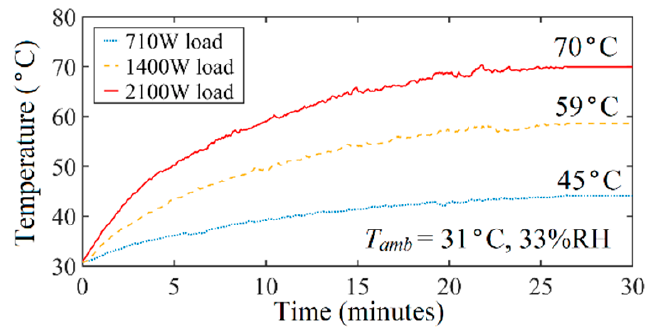
Figure 13. The IGBT-case thermal behavior under three different load